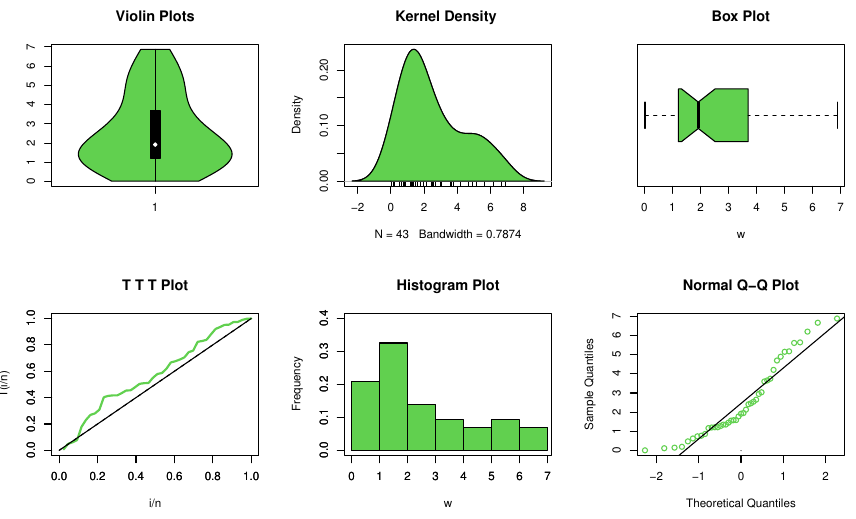
Figure 6. Non-parametric plots for data set